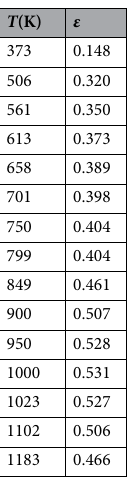
Table 2. Emissivity of